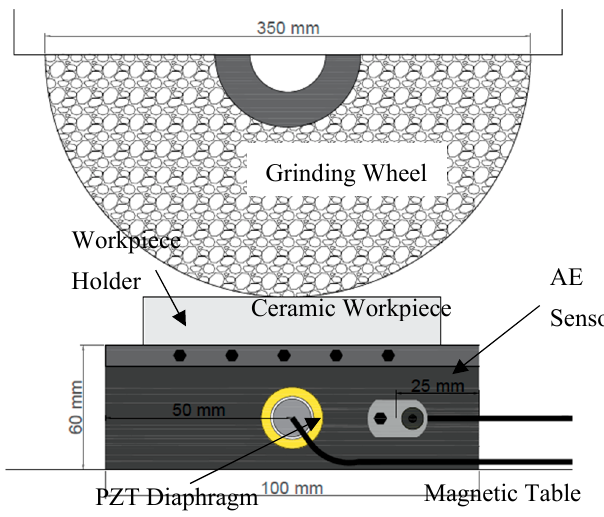
Figure 2. Experimental setup.